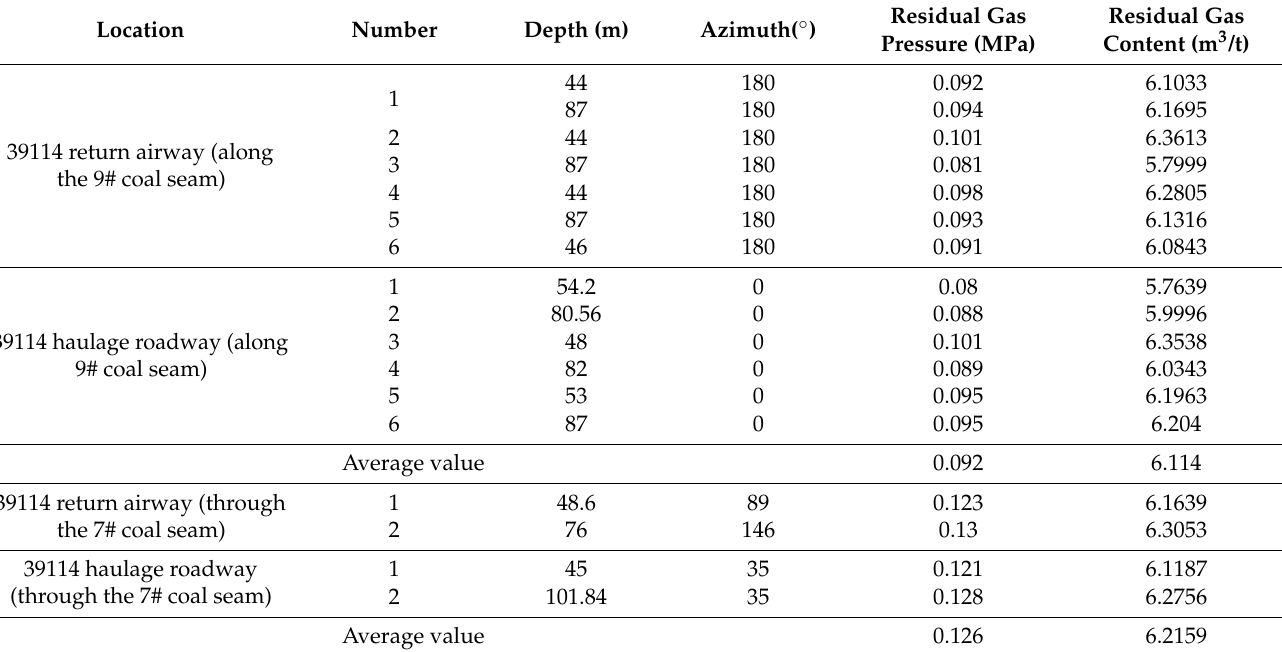
Table 3. Parameters of